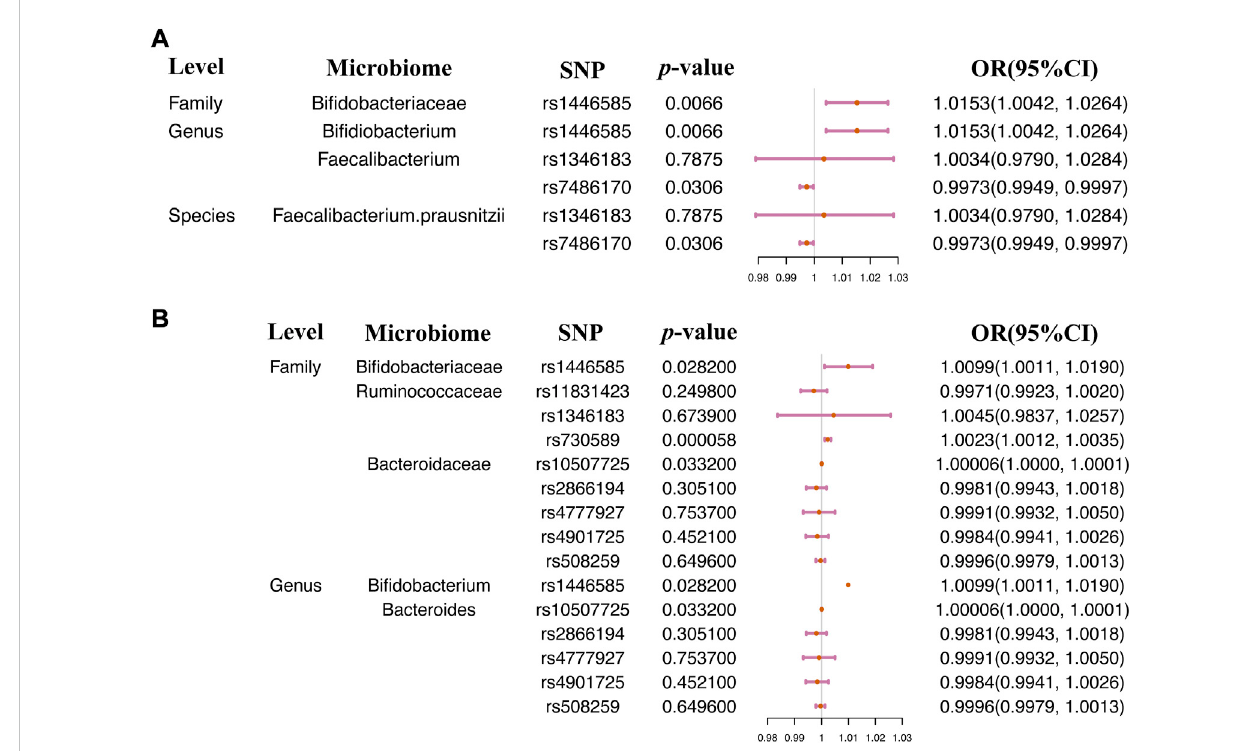
FIGURE 3 Single SNP analysis between the gut microbiome and asthma. Single SNP analysis was performed on two asthma GWAS summary datasets (A) ukb- a-446 and (B)